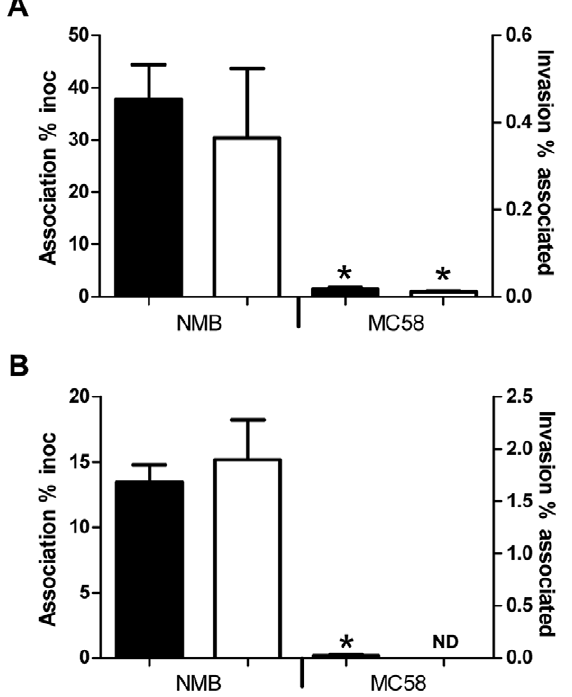
Figure 2. Strain NMB-CDC associates with and invades epithelial cell lines at greater rates than strain MC58. The rates of association and invasion of strains NMB-CDC and MC58 into Detroit 562 epithelial cells (Panel A) and human bronchial epithelial cells 16HBE14 s - (Panel B) were assessed. Attachment as percent of the inoculum (black bars read off the left y-axis) and invasion as the percentage of the associated bacteria (white bars read off the right y- axis) is shown. The average rate ( + /–SEM) from three biological repeats in triplicate following 6 hrs co-incubation is shown. *: p , 0.001 determined by Mann-Whitney t-test compared to strain NMB-CDC, ND: Not Detected, viable counts were below the limit of detection.